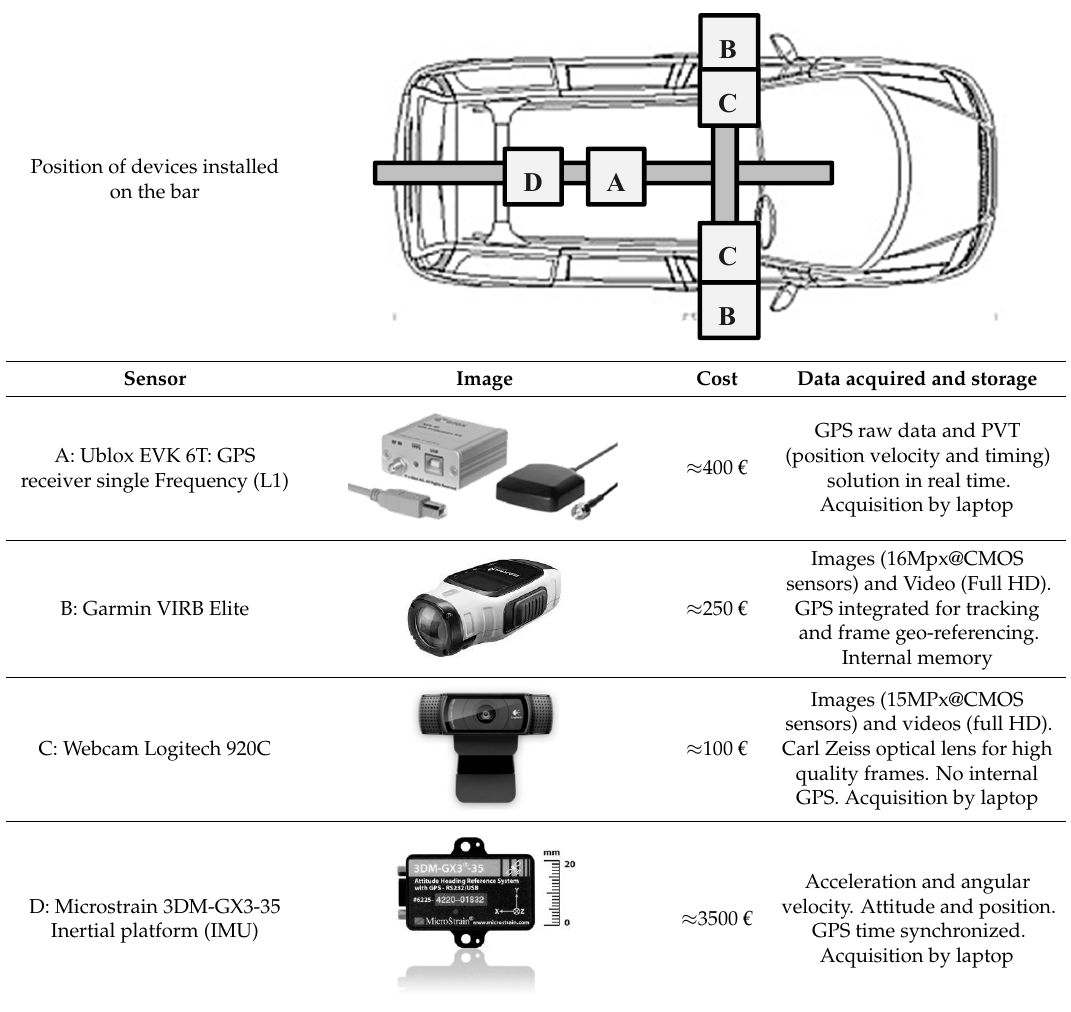
Table 3. Sensors and devices installed on the mobile mapping system (MMS).